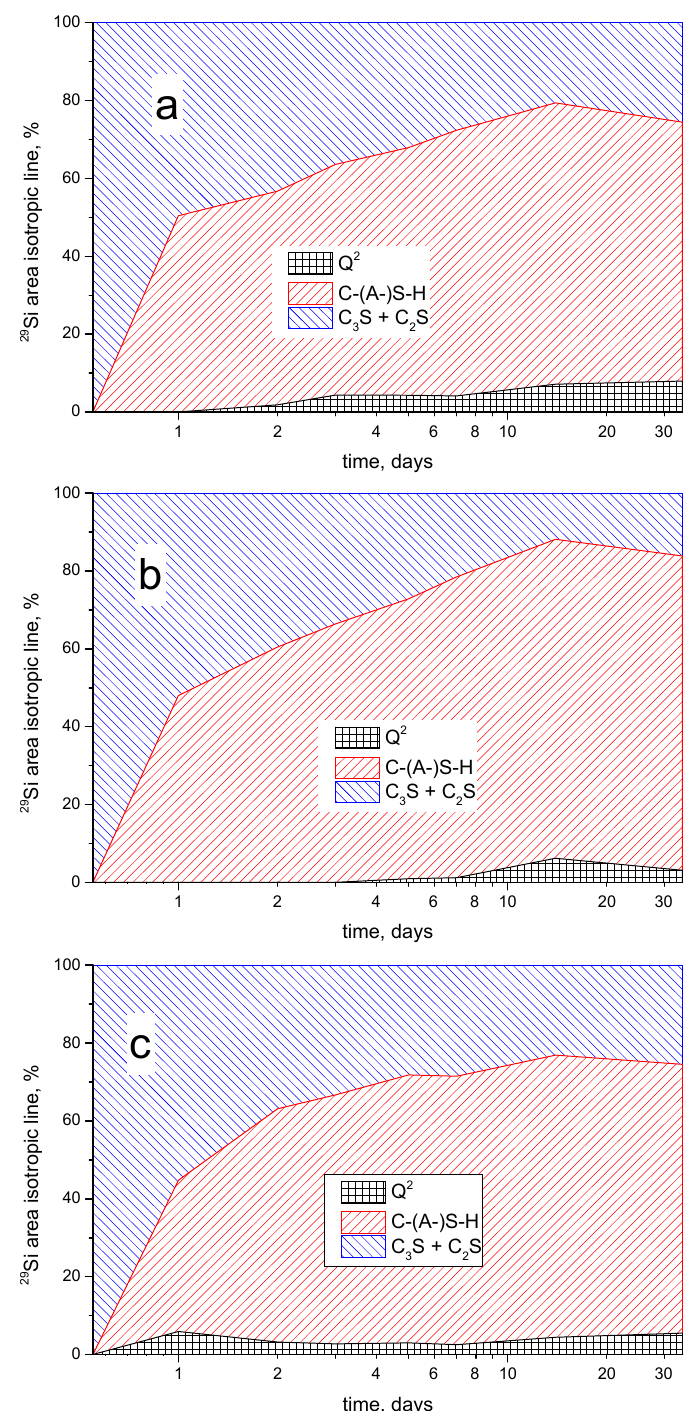
Figure 6. Time-evolution (in logarithmic scale) of the relative integrated areas of the isotropic components recognized in the 29 Si NMR spectra of the samples: C ( a ), CAA ( b ) and CSA ( c